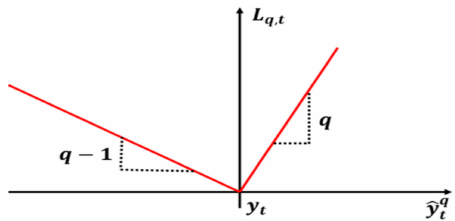
Figure 6. Pinball